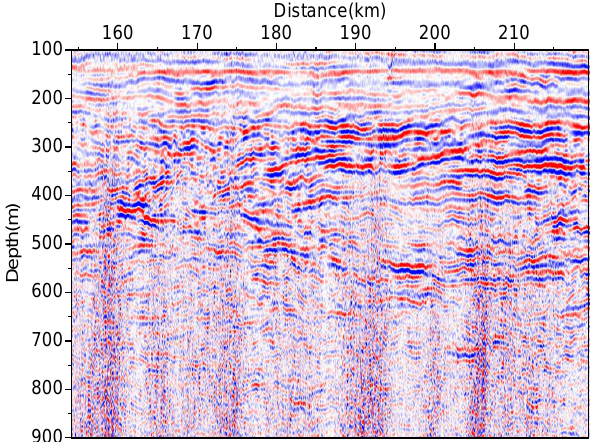
Fig. 3. Detail of the subsurface lens at the end of the north subsec- tion shown in Fig. 2. VE =